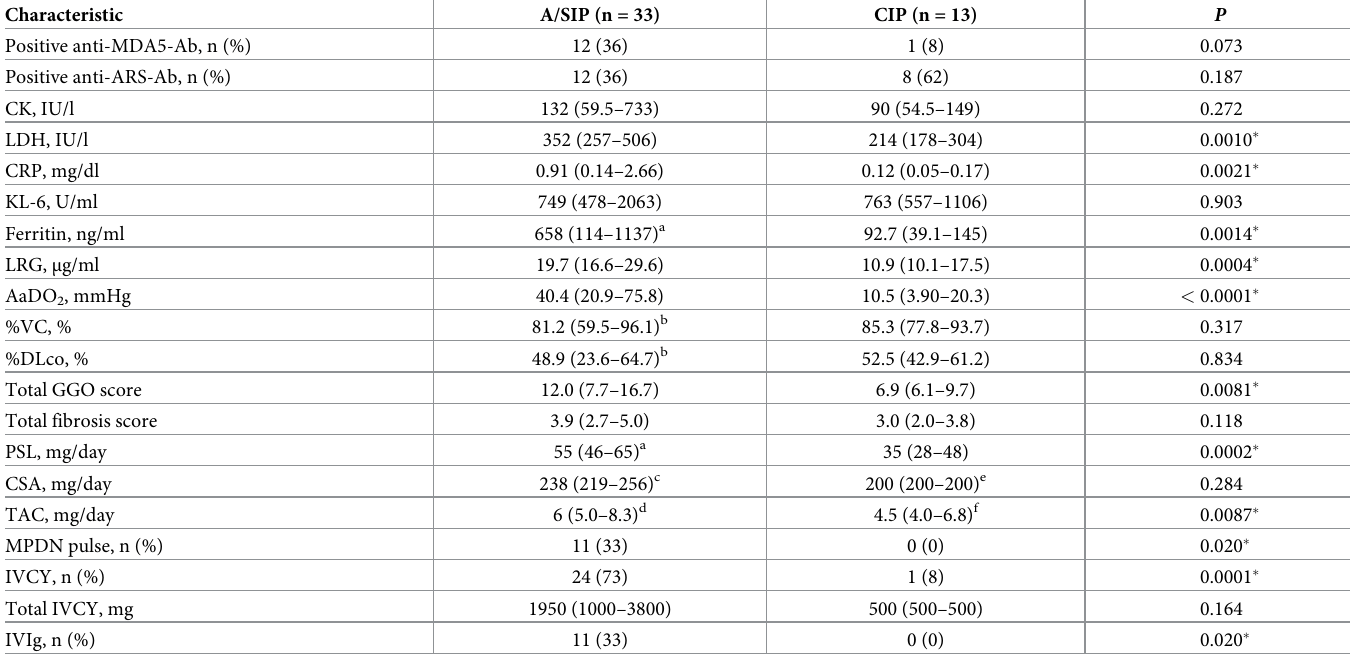
Table 2. Disease indicators and treatment contents of DM-IP on admission of patients with A/SIP and CIP.